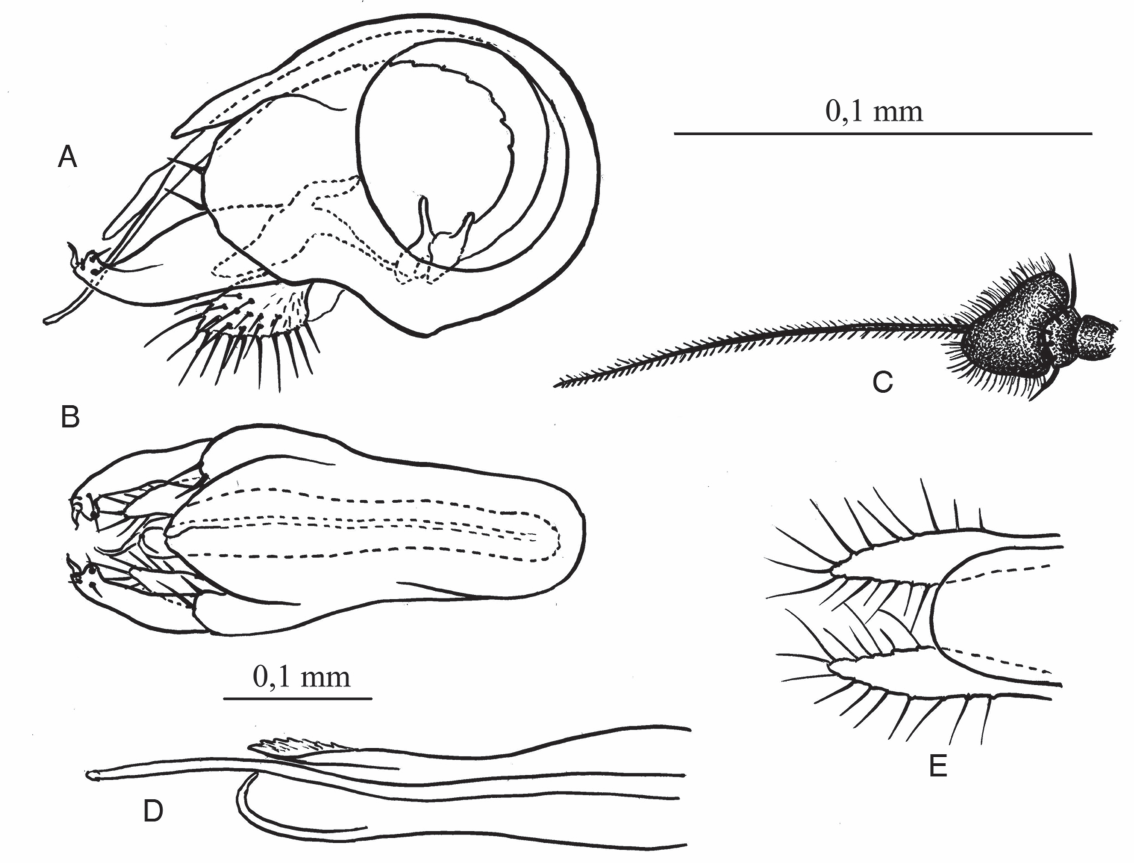
Fig. 2. Chrysotus saigusai Negrobov, Kumazawa & Tago sp. nov., ♂, paratype, coll. 8 Jul. 2012. A . Hypopygium, lateral view. B . Hypopygium, ventral view. C . Antenna. D . Apex of phallus, lateral view. E . Cerci, ventral